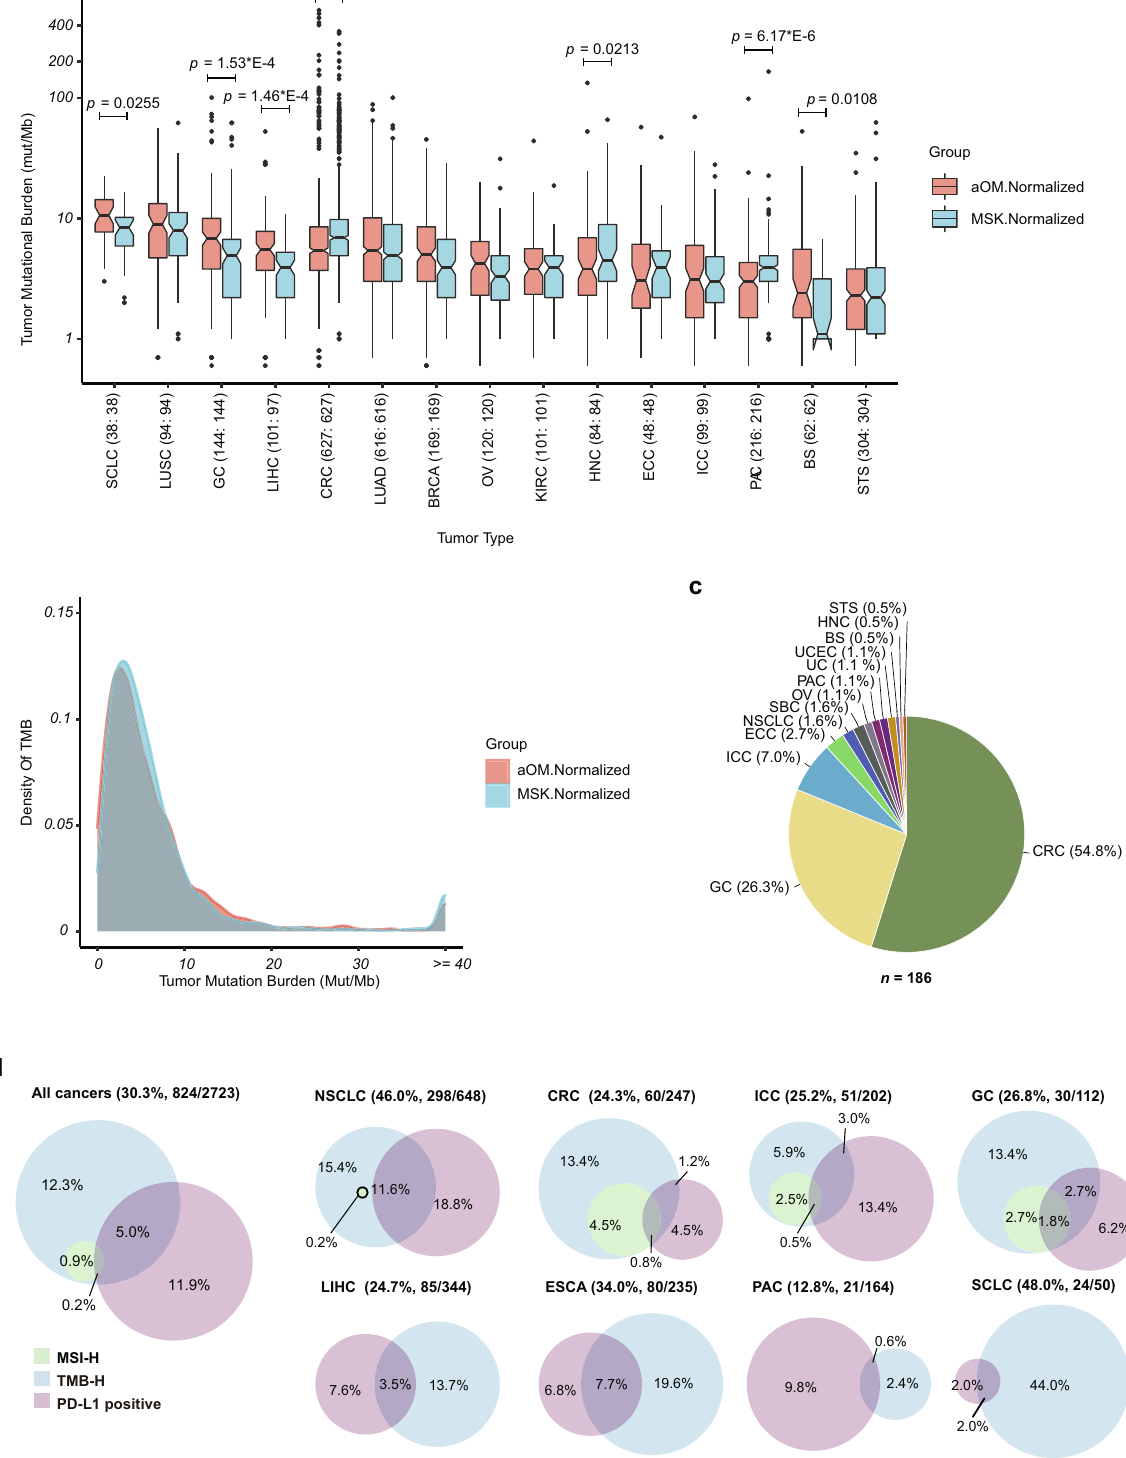
CD274 ampli fi cation and found the co-occurrence of CD274 ampli fi cation with adjacent PDCD1LG2 and JAK2 ampli fi cation (89% and 82% respectively), which are nearby genes in chromosome 9p24.3-9p22.2, associated with advanced stage and poorer outcome 21 . A high frequency of TP53 mutations (78%) was also observed in these tumors (Supplementary Fig.